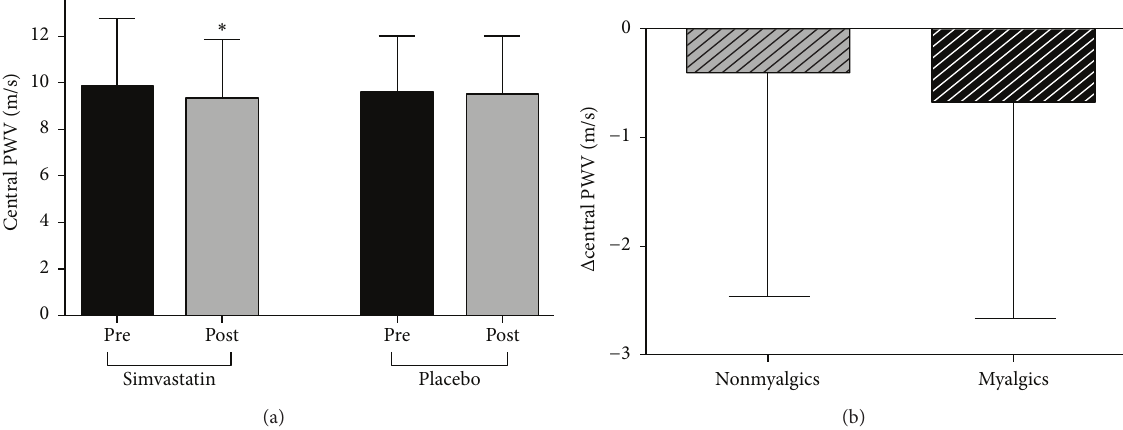
Figure 1: Data are means ± SD. (a) Central pulse wave velocity (PWV) before (Pre) and after (Post) 8wks of simvastatin ( 𝑛 = 100 ) or placebo treatment ( 𝑛 = 100 ); ∗ 𝑃 < 0.05 compared to Pre within a group. (b) Changes (Post-Pre) in central PWV of participants who completed the simvastatin intervention with no development of statin-related muscle symptoms (nonmyalgics; 𝑛 = 76 ) compared with those who reported muscle symptoms with daily simvastatin treatment (myalgics; 𝑛 = 34 ); 𝑃 = 0.51 between groups.